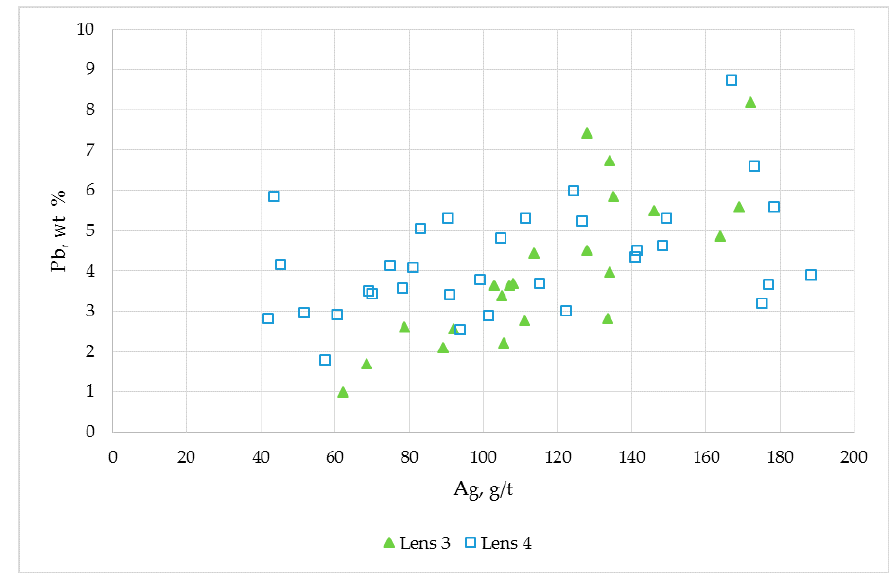
Figure 10. Silver versus Pb drill core interval assays for Lenses 3 ( n = 33) and 4 ( n =